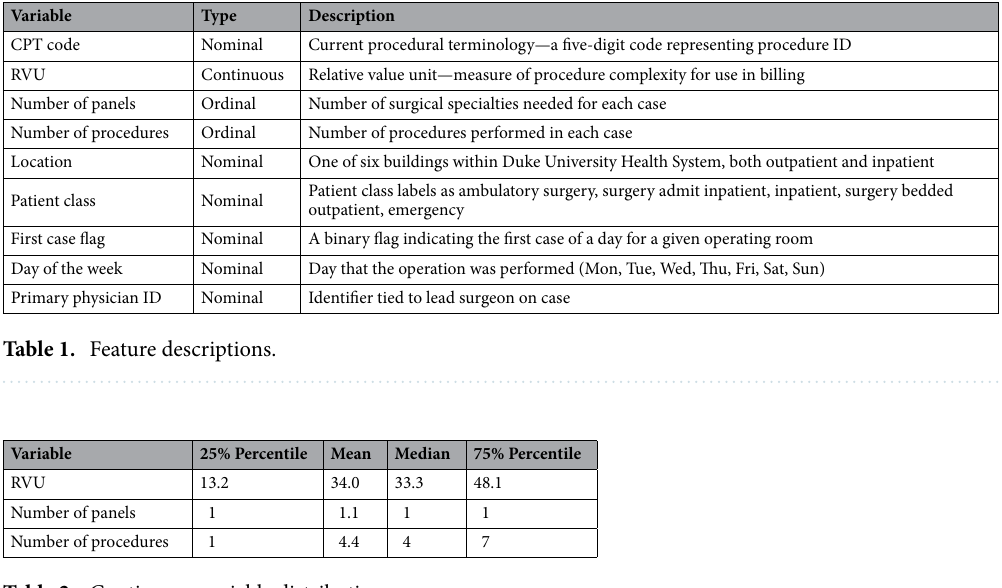
Table 2. Continuous variable